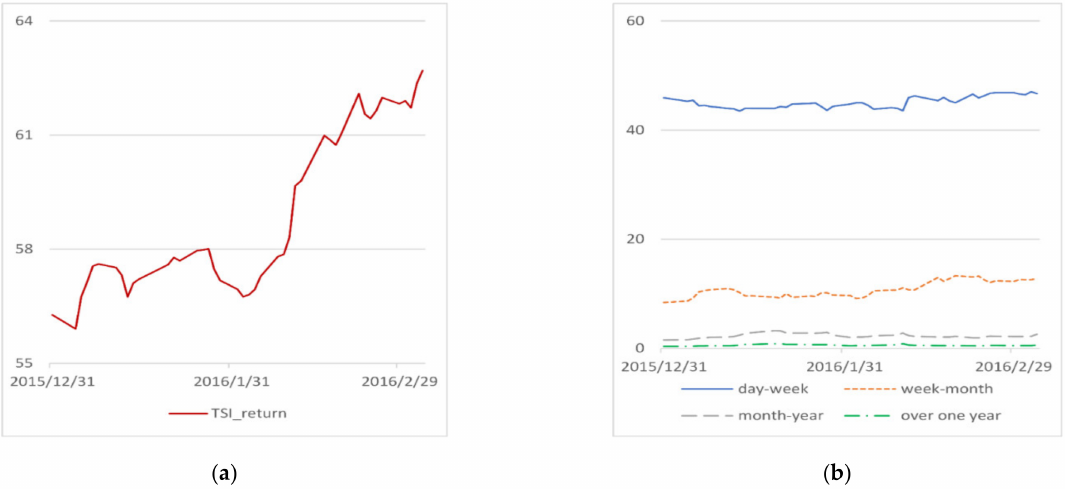
Figure 6. Total spillover of the price return system during the 2015–2016 oil price decline. ( a ) total return spillover. ( b ) frequency decomposition of return spillover.